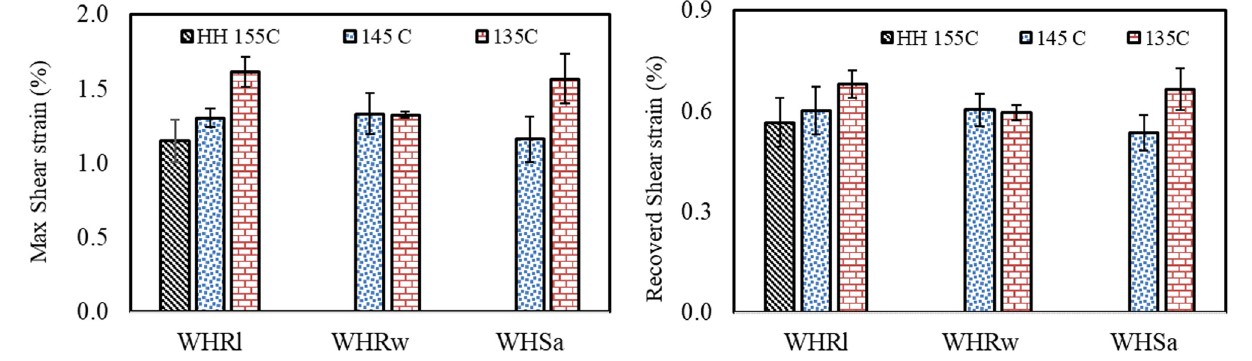
Figure 11: Final maximum shear strain at the termination of the MSCR test.